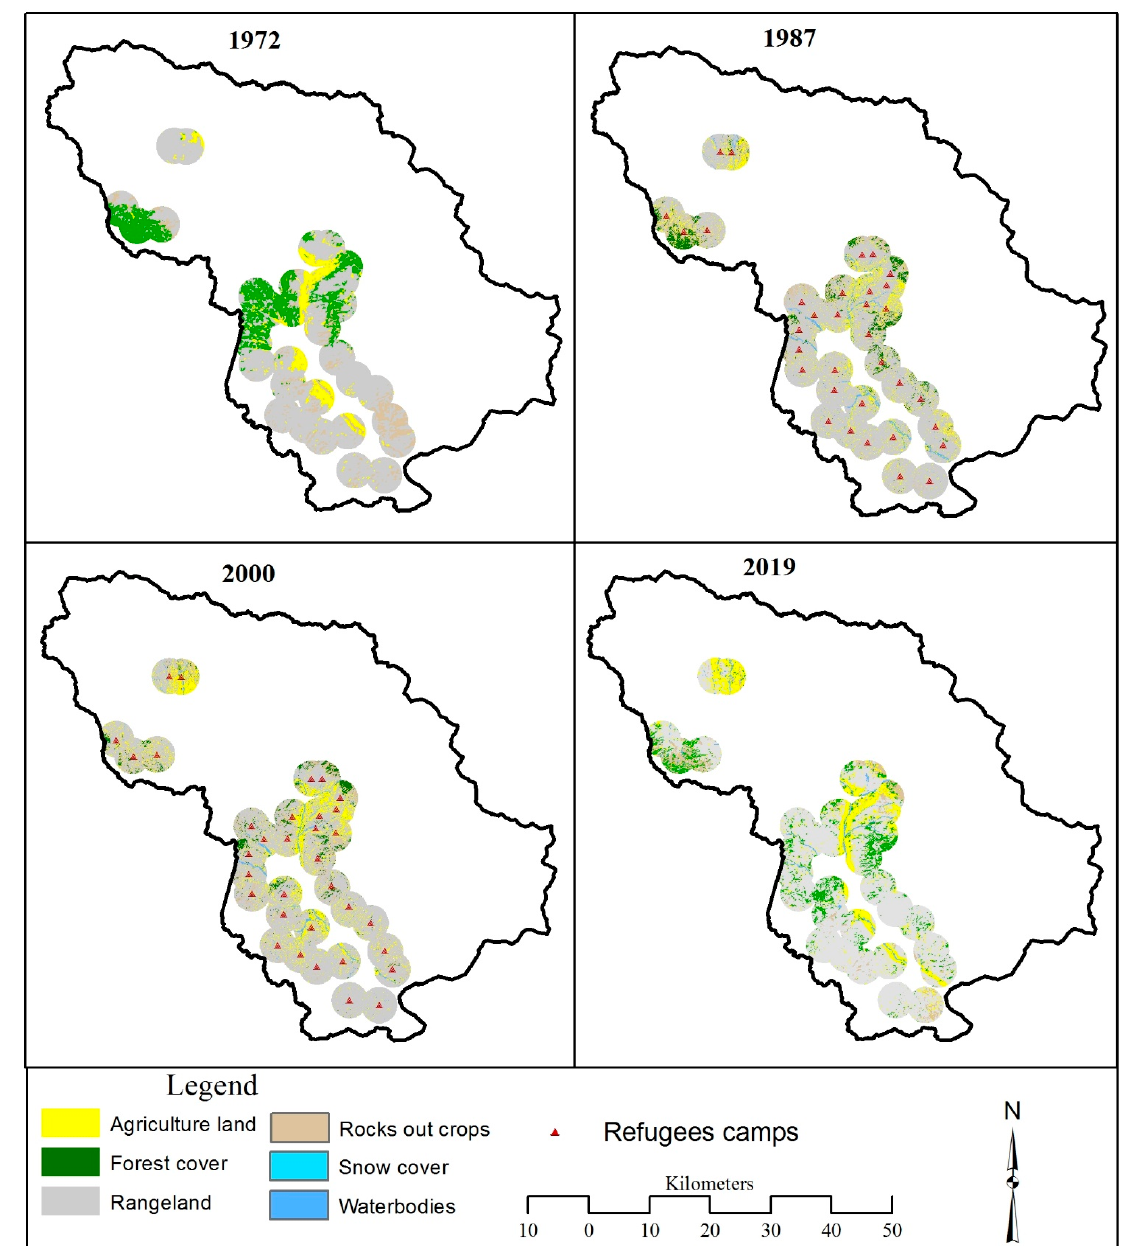
Figure 4. Land use and land cover around 3 km of refugee